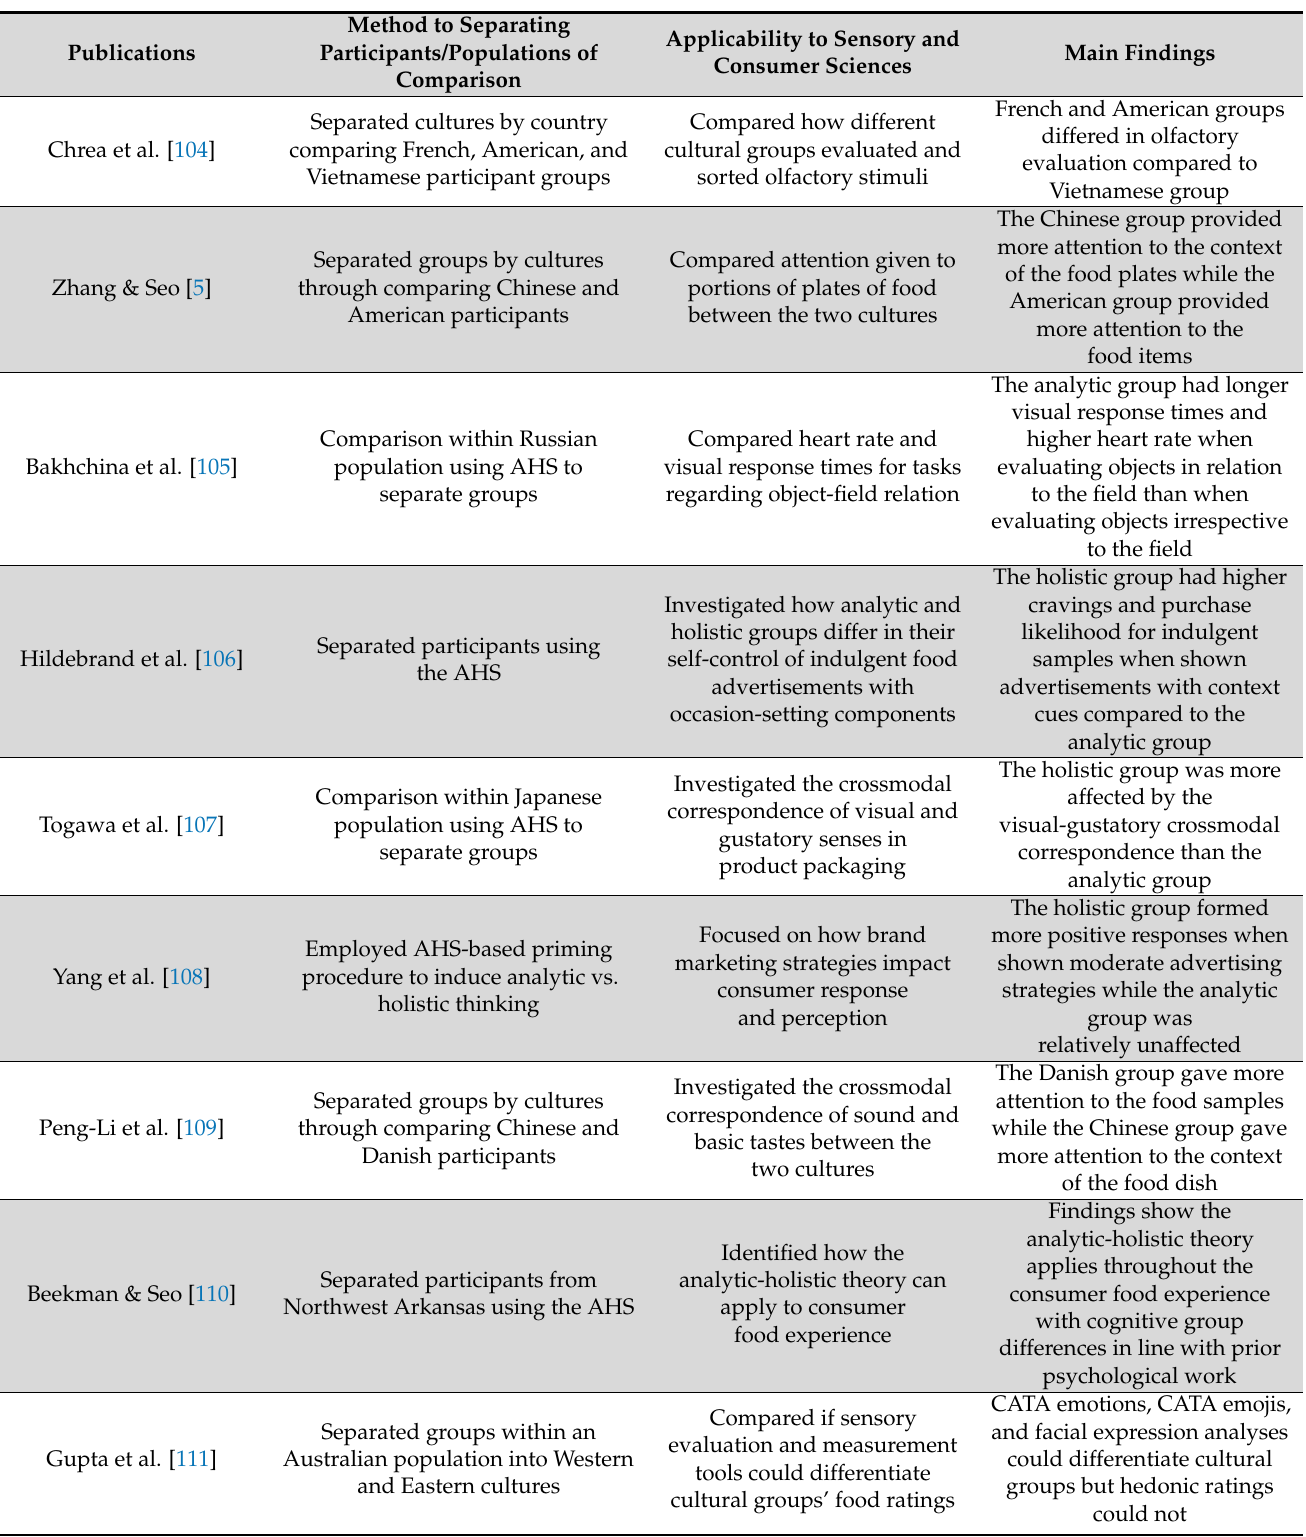
Table 1. Summary of peer-reviewed articles related to the analytic-holistic cognitive theory and its associated cultures with respect to consumer perception and behavior in food-related